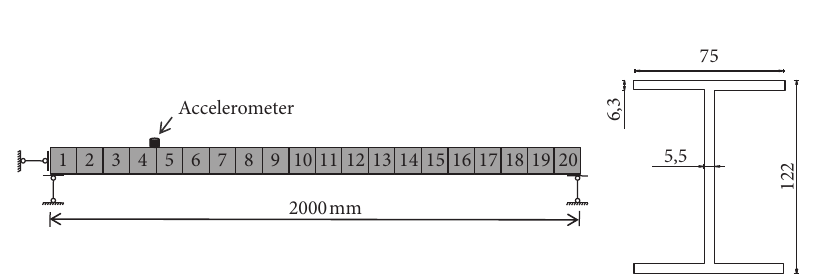
Figure 19: Diagrams of structure and cross section.